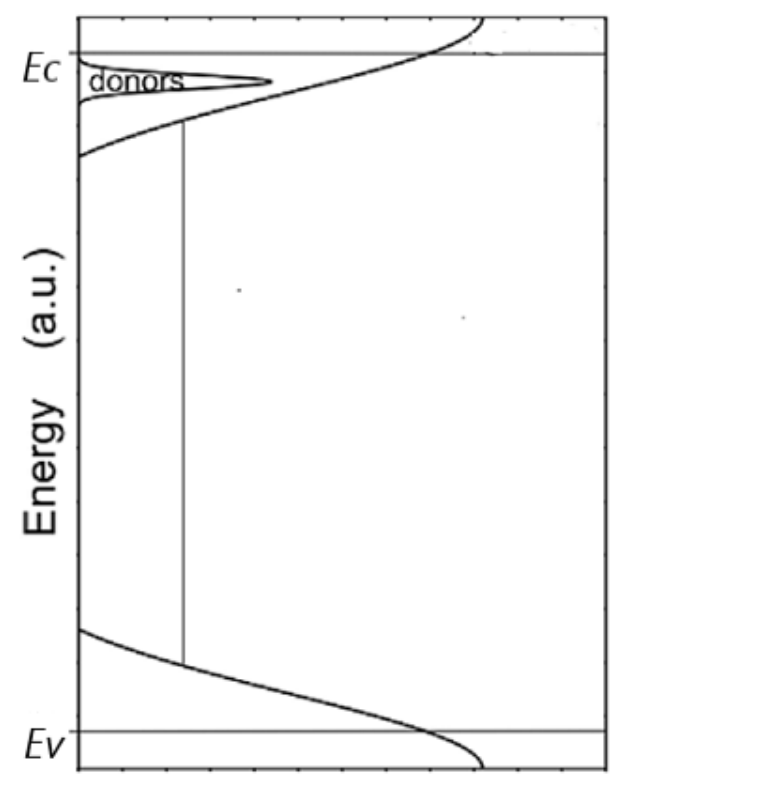
Figure 7. Schematic representation of an n-type semiconductor with valence band ( E v ) and conduction band ( E c ), and the donor states and the Urbach states in the energy gap.